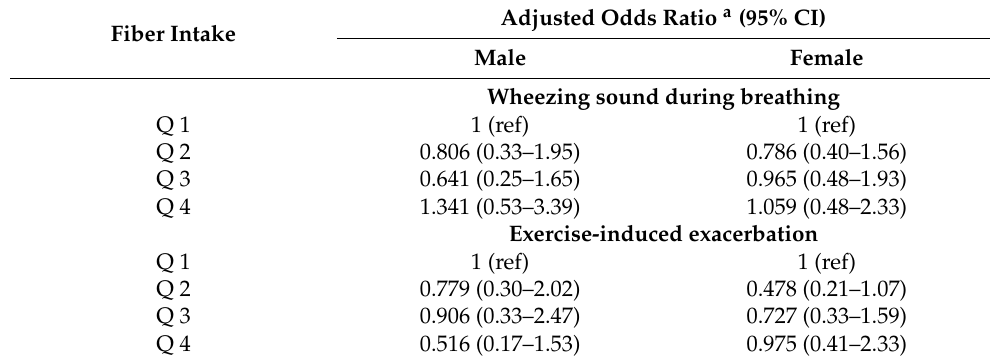
Table 4. Multivariate logistic regression analysis of the association between fiber intake and asthma- related conditions.